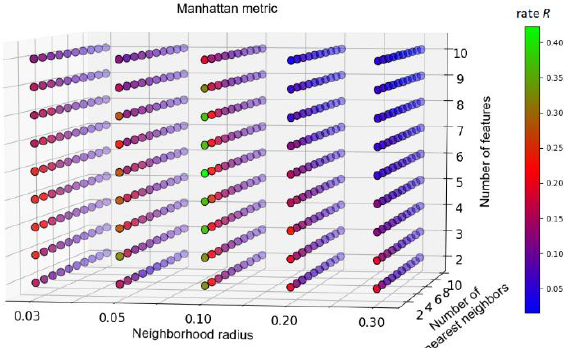
Figure 5. Results of the experiments for Manhattan metric